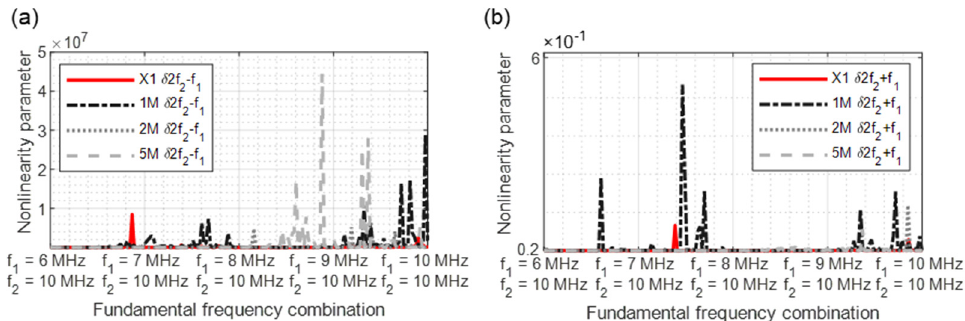
Figure 19. Nonlinearity parameter: ( a ) δ 2f 2 − f 1 ; ( b ) δ 2f 2 +f 1 .